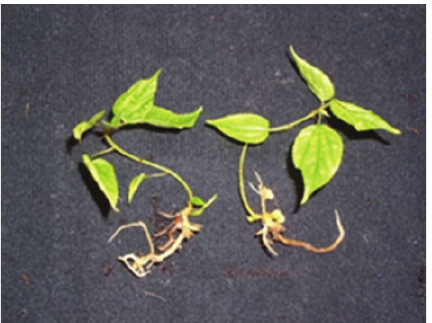
Figure 3: In vitro plantlets 2 months after acclimatization in soil. Bars =